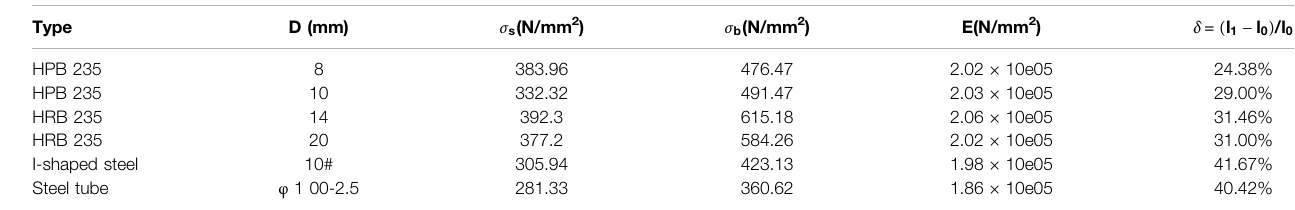
TABLE 4 | Mechanical behavior of steel bars (Xiang et al., 2017; Xiang et al., 2019).